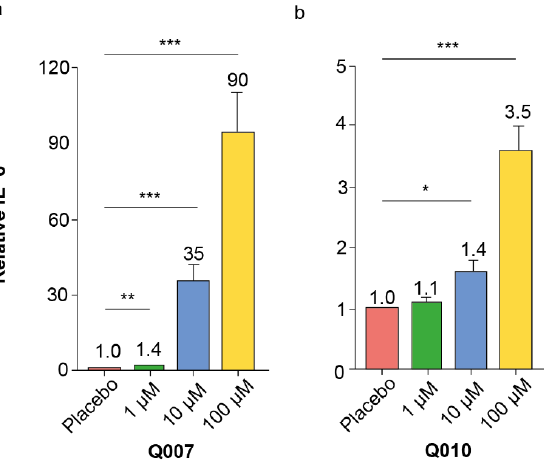
Figure 3. Results of IL-6 ELISA after 24 h incubation of human PBMCs with different concentrations QSP. ( a ) Q007; ( b ) Q010. Bars and numbers on top represent means, with error bars representing s.e.m. Asterisks indicate the following criteria of statistical significance: * p ≤ 0.05 ** p ≤ 0.01 *** p ≤ 0.001 (two-sided t-test between placebo and specific QSP concentration). Table 2. Plasma and cell medium half-life values of four